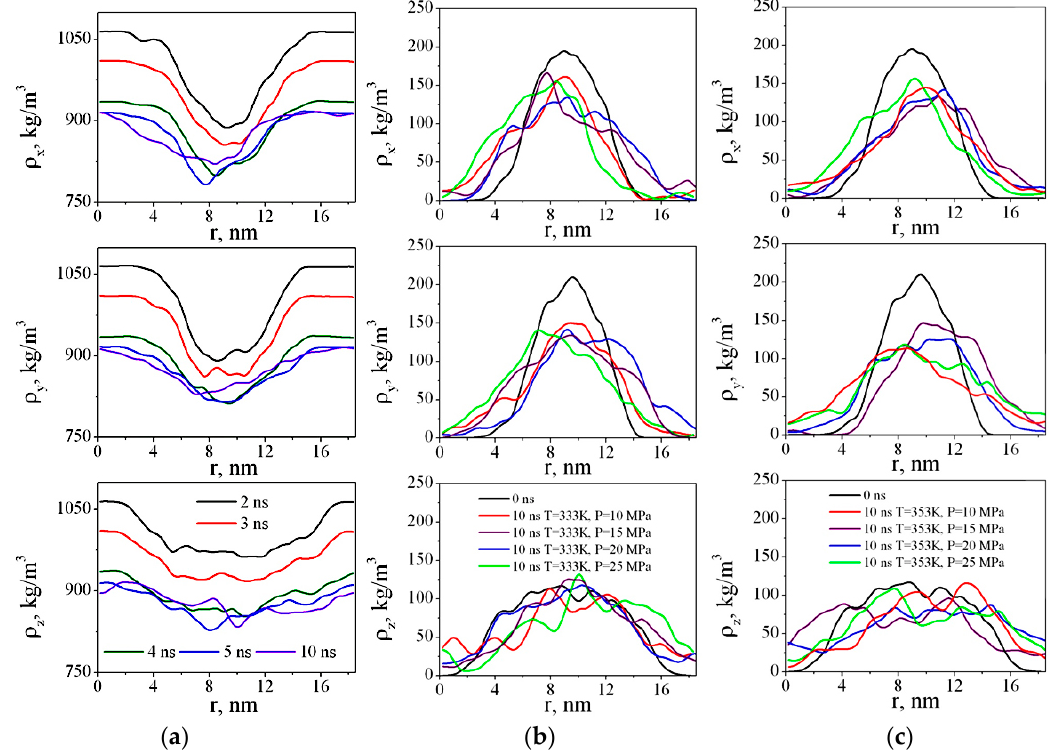
Figure 7. Time dependences of CO 2 density in simulation boxes in x, y, and z directions at 333 K and 25 MPa ( a ), PMMA densities in x, y, and z directions at the beginning and at the end of the simulation at P = 10–25 MPa and 333 K( b ), 353 K ( c ).